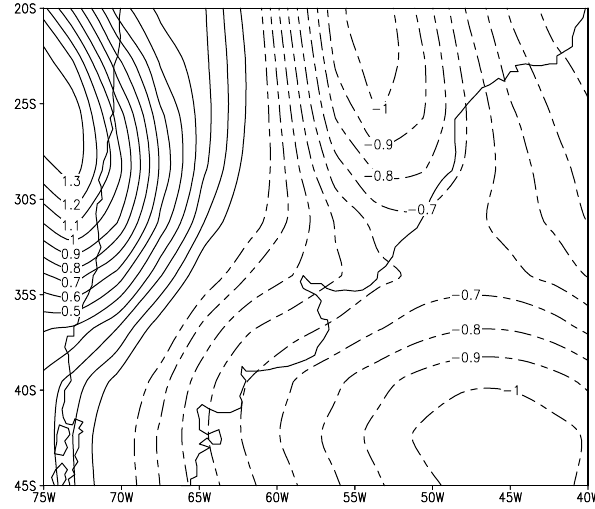
Figure 2 : Surface temperature anomalies (ºC) on day 10 of integration corresponding to the mean Fig. 2. Surface temperature anomalies ( ◦ C) on day 10 of integration corresponding to the mean winter basic state experiment with the winter basic state experiment with the forcing at 170ºE-15ºS forcing at 170 ◦ E–15 ◦